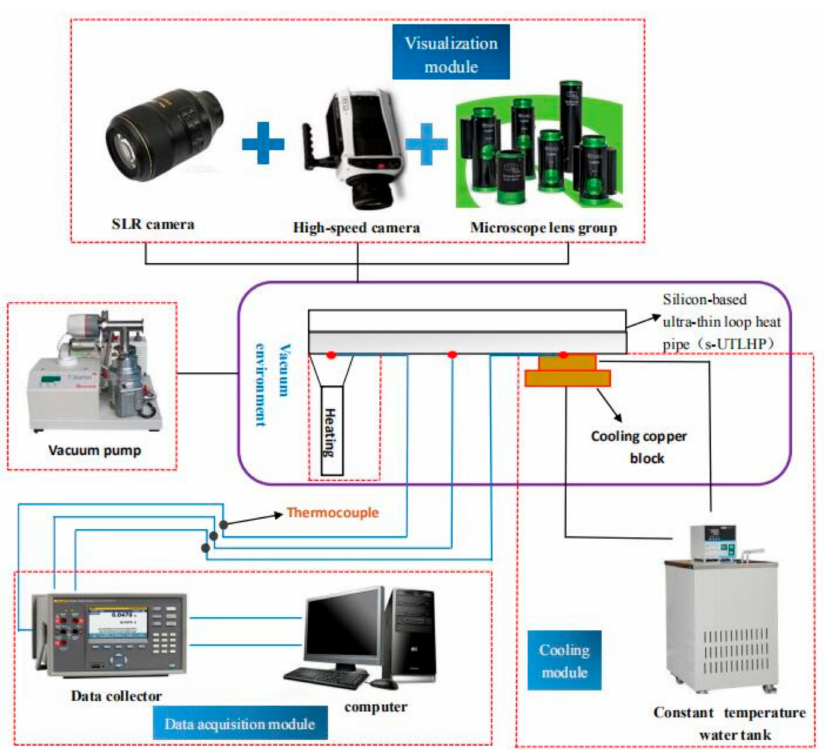
Figure 3. Visualization of the heat transfer experiment system.